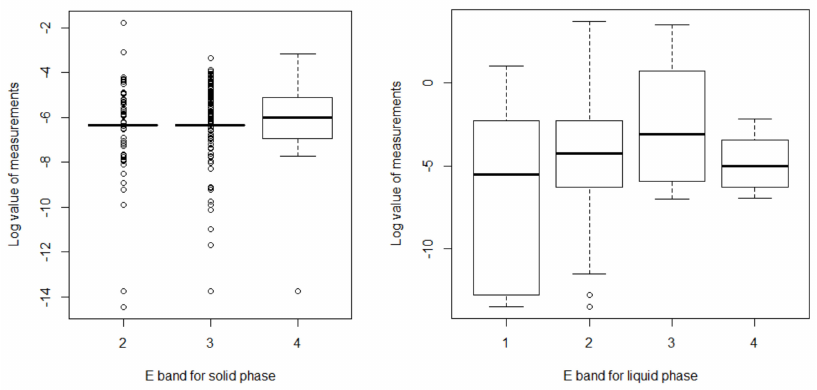
Figure 6. Exposure band (E band) for each phase.